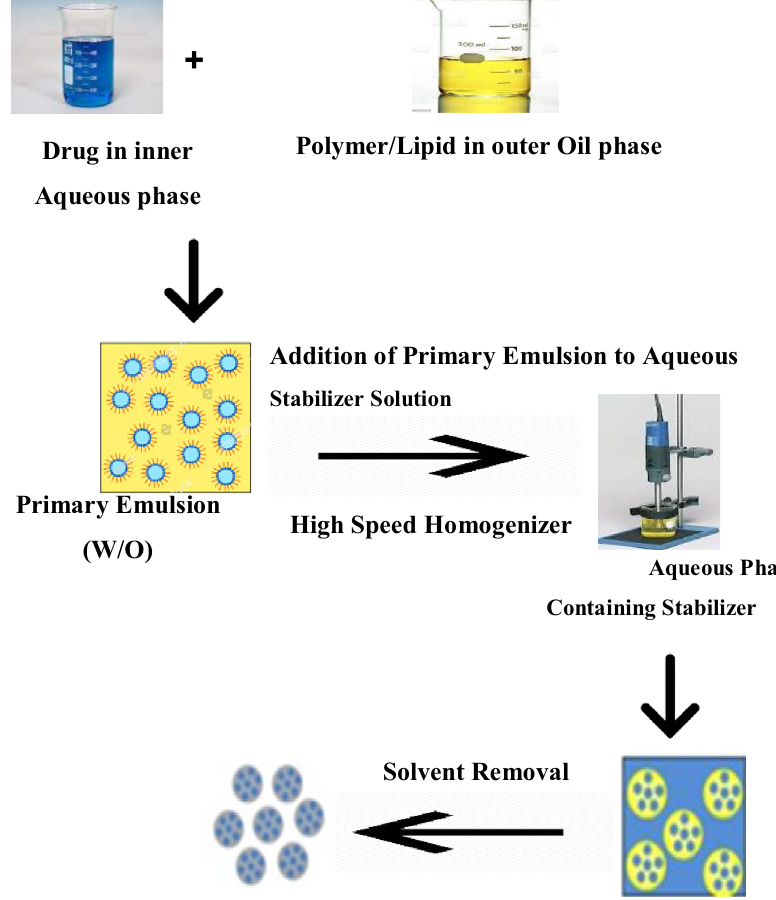
Fig. 3 The schematic diagram for the double emulsion sol- vent evaporation method